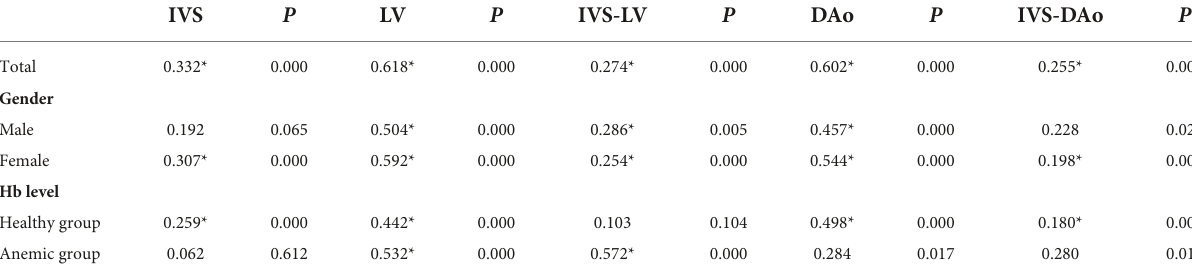
TABLE 6 Correlation coefficients of indicators with Hb level in LDCT group.